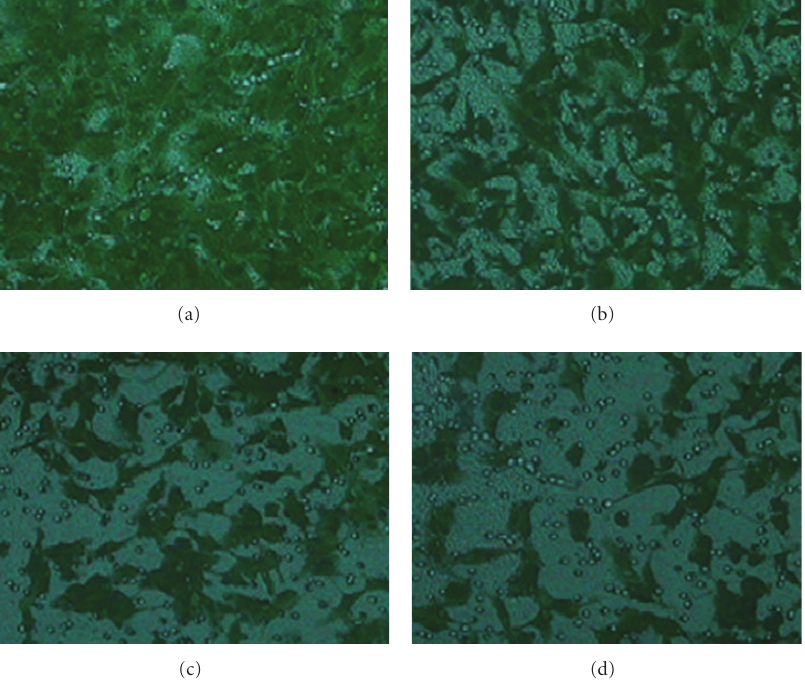
Figure 3: The e ff ect of the standardized RVS extract on the invasiveness of human fibrosarcoma HT1080 cells using Boyden chamber assay. (a) Control. (b) RVS 50 μ g/mL. (c) RVS 100 μ g/mL. (d) RVS 200 μ g/mL showing inhibitory e ff ect on invasion compared to the